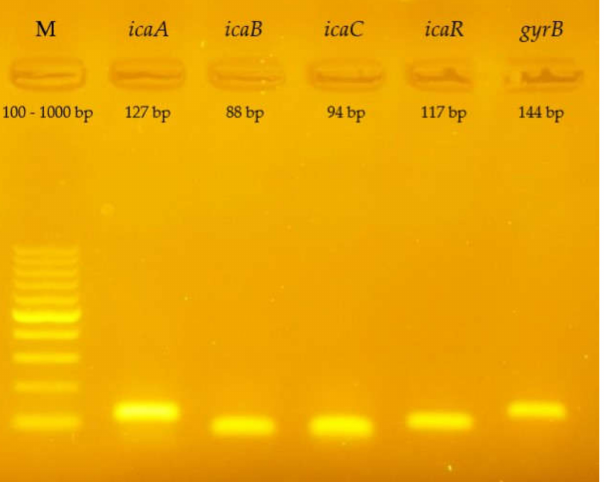
Figure 7. Visualization of the gene amplification products of the icaADBC operon and the icaR gene ( S. epidermidis ATCC 35984) in a 2% agarose gel stained with SimpleSafe EurX, Poland; icaA —127 bp, icaB —88 bp, icaC —94 bp, icaR —117 bp, gyrB —144 bp; bp—base pairs; M—marker. The results obtained for the four genes tested ( icaA , icaB , icaC , icaR ), with division into individual strains of S. epidermidis , are presented below in Figure 8A–D, Figure 9A–D, Figure 10A–D and Figure 11A–D.